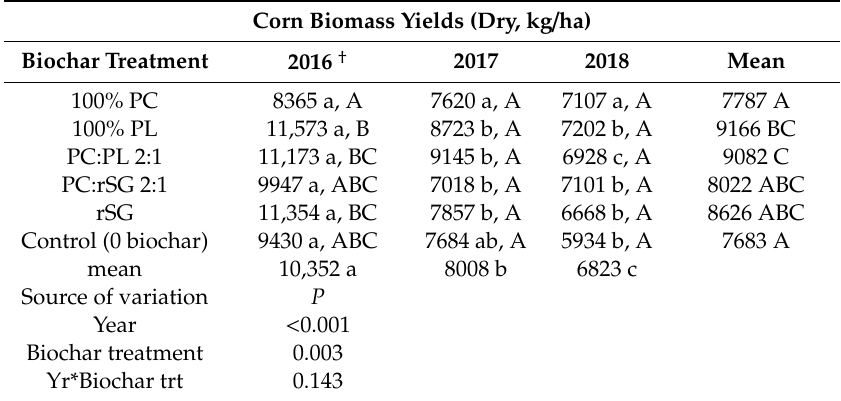
Table 6. Comparison of annual mean corn biomass yields (above ground biomass minus corn grain weights; n = 4; PC = pine chip; PL = poultry litter, rSG = raw switchgrass